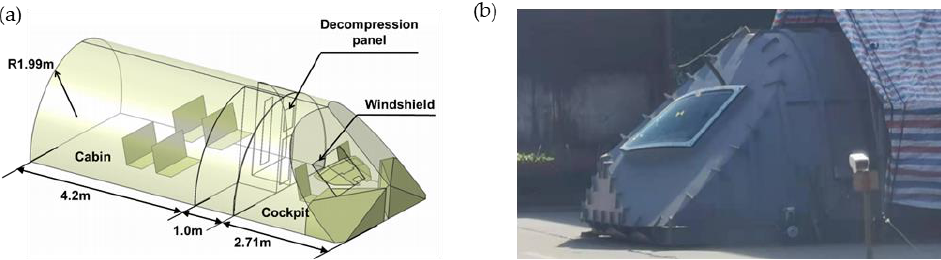
Figure 8. ( a ) Model of the experimental compartment and ( b ) picture of the real experimental compartment. Table 2. Experimental